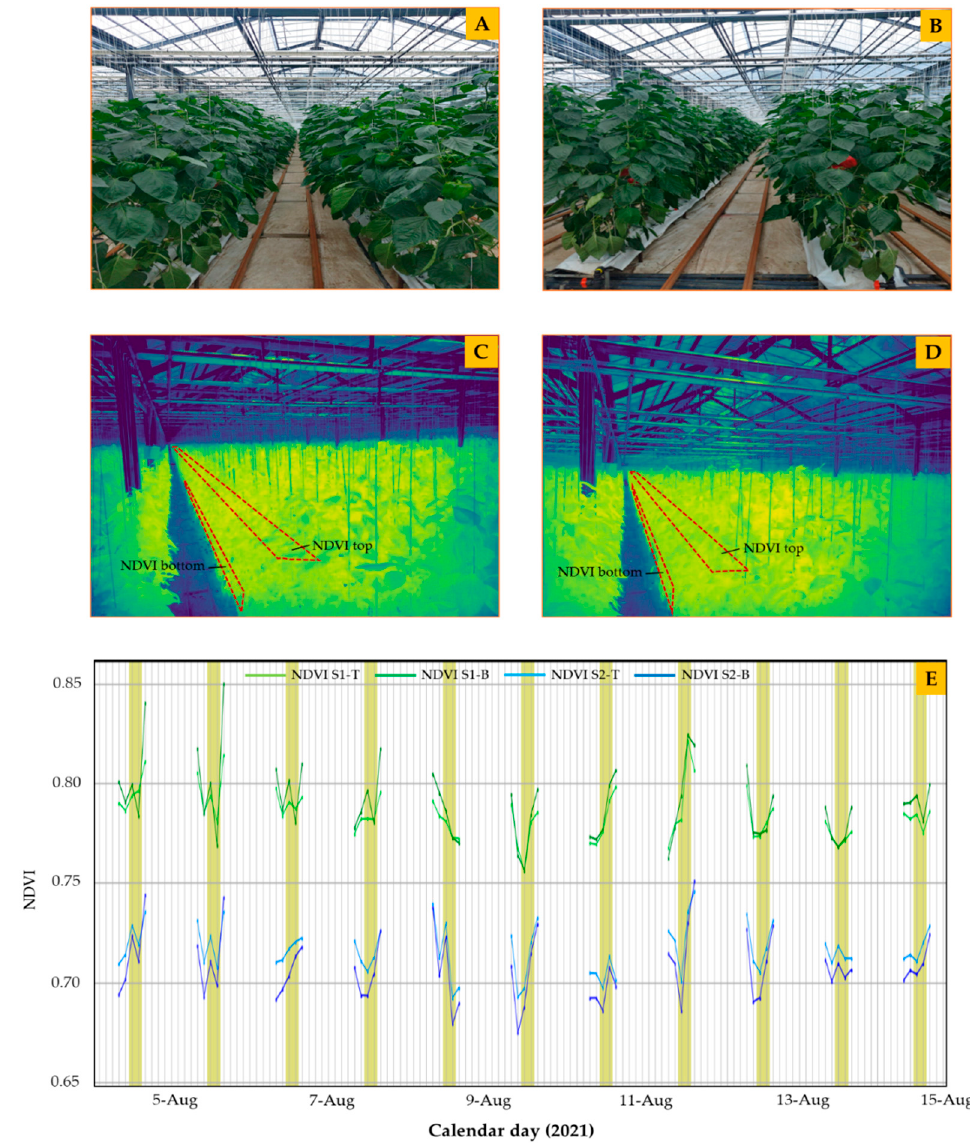
Figure 5. Effect of shade screens on plant growth of S1 ( A ) and S2 ( B ) treatments. Image of normalized difference vegetation index (NDVI) in S1 ( C ) and S2 ( D )-treated plants. Graph of NDVI in S1 and S2 treatments ( E ). T and B indicate top portions at 2 m height and bottom portions at 1 m height of the plant, respectively.